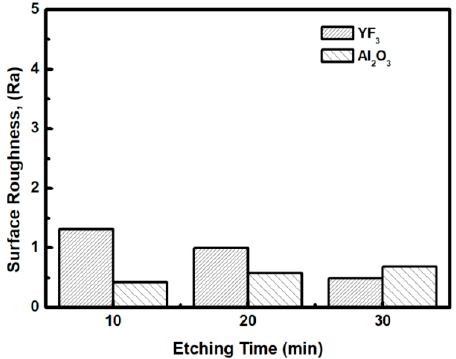
Figure 6. Etching depths of the YF 3 film and Al 2 O 3 substrates after different CF 4 /O 2 plasma exposure times.